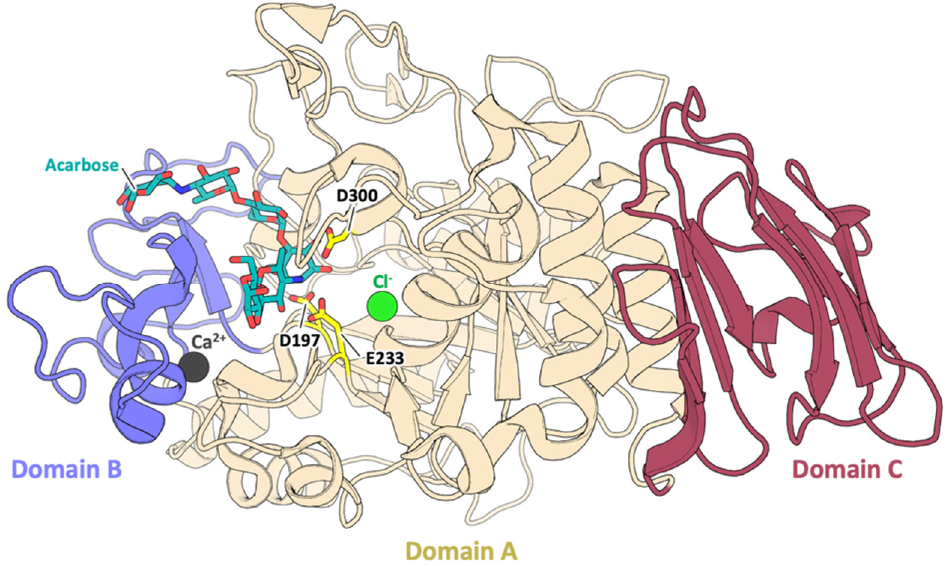
Figure 1. Folding and domains of α -amylases. Ions are represented as spheres, the catalytic triad and the substrate as sticks and the protein as cartoon (PDB ID: 1mfv; human α -amylase). The three domains (A, B, and C) are shown in different colors.